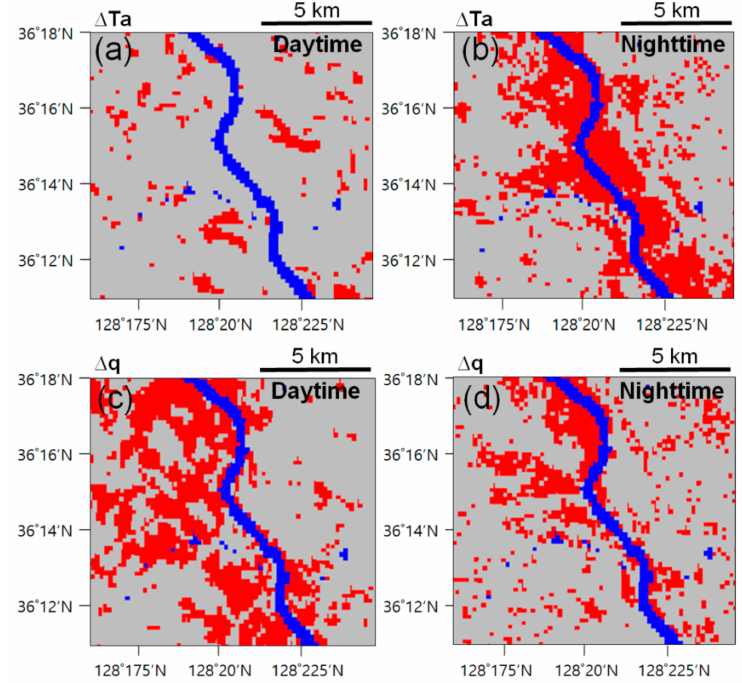
Figure 9. Horizontal distribution of a paired t -test result for ∆ Ta ( a , b ) and ∆ q ( c , d ) in daytime ( a , c ) and nighttime ( b , d ) for Case2. Area with significant change ( p < 0.05) is marked in red, and the water area after weir construction is marked in